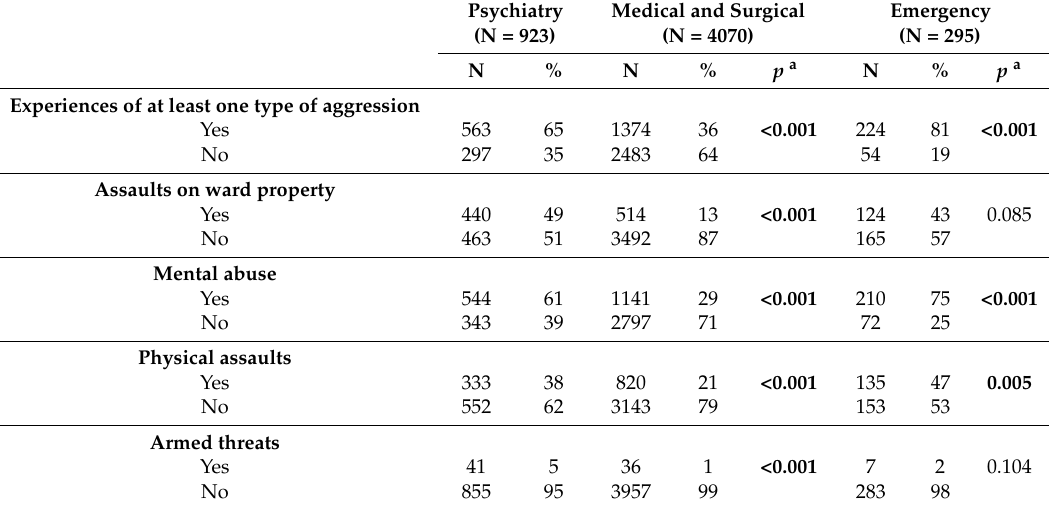
a p -value, comparison with psychiatric nurses.